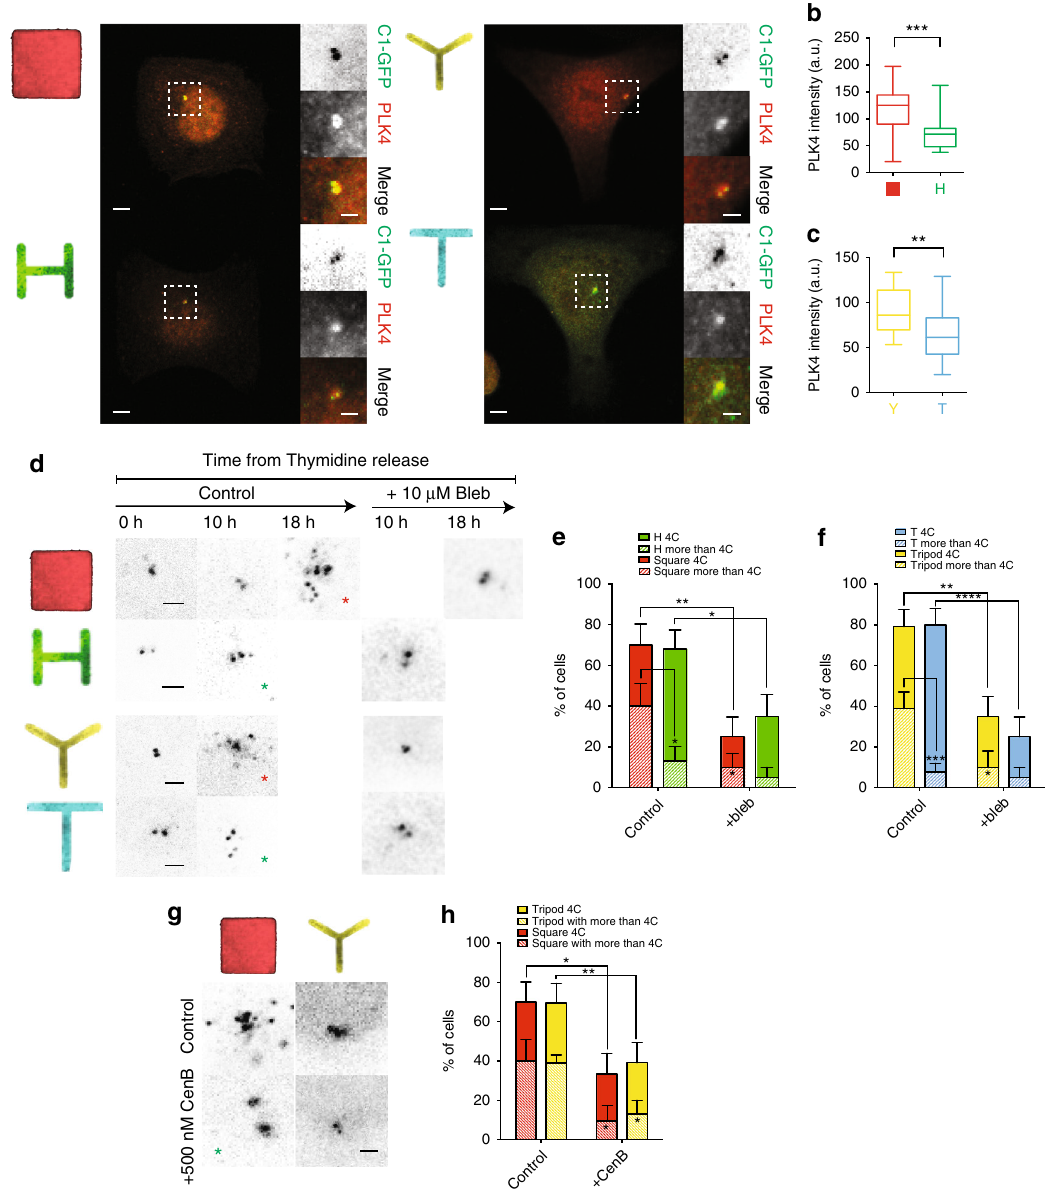
Fig. 6 Acto-myosin force organization regulates PLK4 recruitment at the centrosome and centriole duplication. a Images of cells expressing C1-GFP immunostained for PLK4 (scale bar = 5 μ m). Dashed boxes indicate zoomed section presented in panels on the right of the pictures. Zoomed panels (scale bar = 2 μ m): from top to bottom: C1-GFP, total PLK4, Merge. b , c PLK4 mean fl uorescent intensity for all cells analyzed. Between 20 to 30 cells were analyzed for all the conditions. d Representative pictures of C1-GFP HeLa cells arrested in G1 phase with a double thymidine block and then analyzed for presence of duplicated centrosomes (4C and more) at different time points from the release of the thymidine block. Cells were either untreated (Control) or treated with 10 μ M Blebbistatin (Bleb). Red asterisks indicate misduplicated centrosomes and green asterisks indicate correct duplication. Pictures were analyzed as maximal projection of the z-stack spanning through all the volume of the cell. e , f Quanti fi cation of duplicated centrioles (4C and more than 4C) at the time point at 10 h from Thymidine release for H, Tripod and T, and 18 h for Square (Square n = 20 cells; H n = 25 cells; Tripod n = 24 cells; T n = 25 cells) and for the corresponding blebbistatin (Bleb) treated cells (Square + Bleb n = 20 cells; H + Bleb n = 20 cells; Tripod + Bleb n = 20 cells; T + Bleb n = 20 cells). Quanti fi cation for Square and H shapes ( e ) and Tripod and T ( f ). Error bars represent s.e. g Representative pictures of C1-GFP arrested in G1 phase with a double thymidine block and then analyzed after 16 h of CentrinoneB (CenB) treatment versus untreated (scale bar = 2 μ m). h Quanti fi cation of more than four centrioles and more than four centrioles in untreated and 16 h CentrinoneB (CenB) treated Square and Tripod cells (square n = 20 cells; Square + CenB n = 20 cells; Tripod n = 20 cells; Tripod + CenB n = 23 cells). Plain bars represent percentages of cells with four centrioles, patterned bars represent percentage of cells with more than four centriole. * is the statistics ( p < 0.05) for treated vs untreated % of cells with more than 4C in Square and in Tripod. Error bars represent s.e. p -values were obtained with unpaired two-tailed t -test; * p < 0.05, *** p < following question: how do acto-myosin forces change during cell separation distance range varies across cell cycle (up to 2 μ m in cycle? In two very recent publications, the level of traction forces G1-arrested cells; up to 6 μ m in asynchronous cells). We did not was shown to increase in the G1, reach a plateau in S phase, and explore in detail why different phases of the cell cycle have precise then decrease during G2 34,35 . Altogether our data and these centriole separation responses, but this fi nding raises the